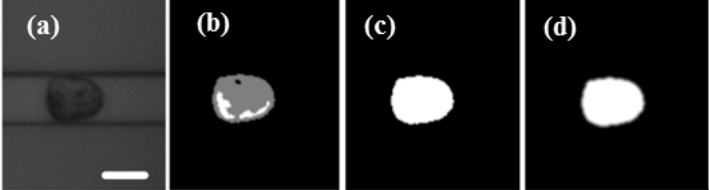
Figure 2. ( a ) The region of interest of video was determined and the image smoothed with Gaussian filtering. ( b ) Background subtraction. ( c ) The hole in the contour was filled. ( d ) The image was filtered and the contour was processed by convex hull. Scale bar: 20 μm.